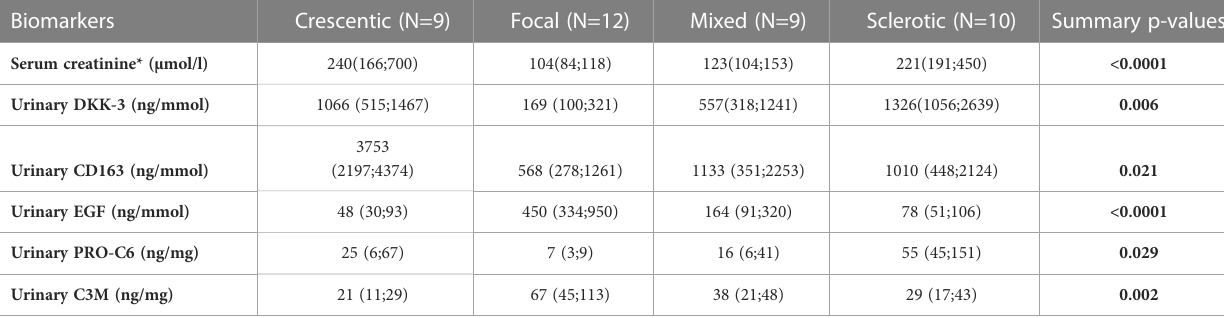
TABLE 6 Biomarker concentration in serum and urine in the different bioptic classes (total N=40).